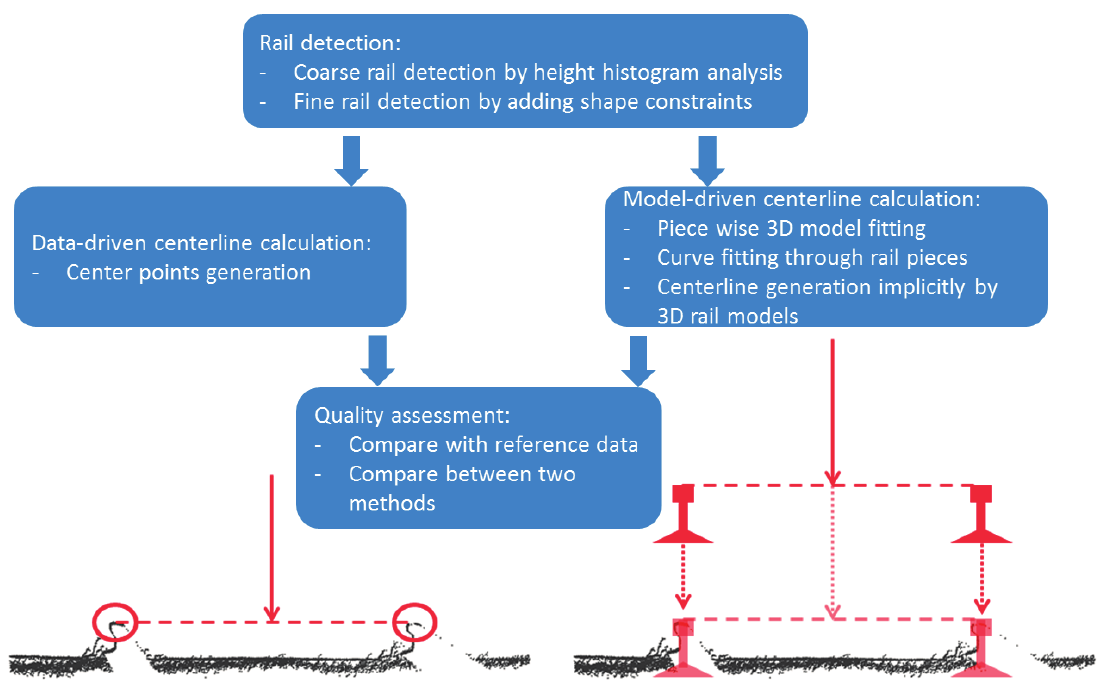
Figure 3. Schematic workflow from rail detection to data-driven and model-driven centerline